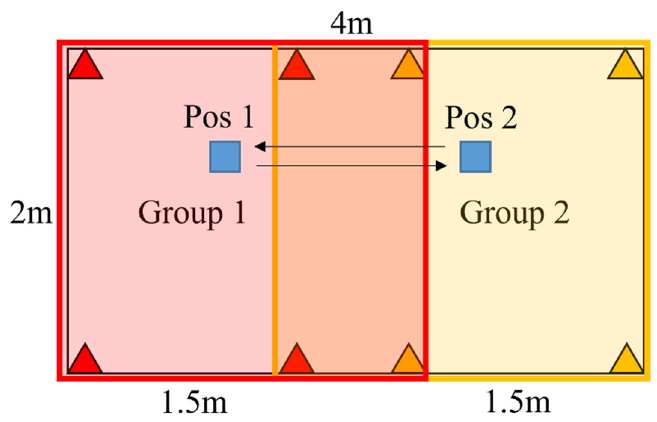
Figure 20. Latency test deployment.